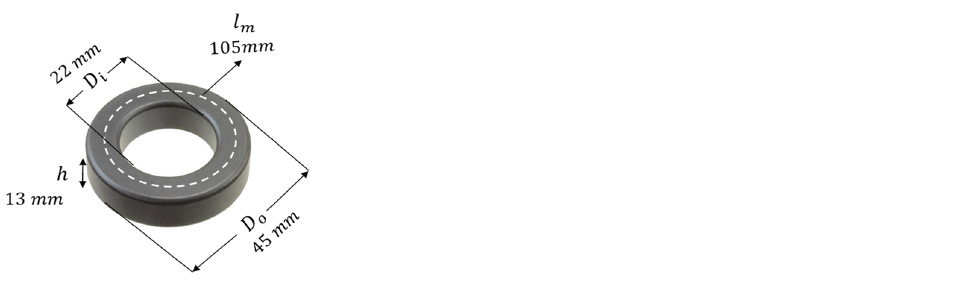
Figure 7. Required measurements for the application of the ASTM A772/A772M standard. As shown in Figure 6, it was necessary to generate a high-frequency sinusoidal current, which was generated by implementing the resonant inverter, as seen in Figure 8, where the inductor of the resonant network contains the test core and must be in resonance with the capacitor. The design of the resonant inverter takes into account the inductance of the primary winding of each inductor “ L p ”, where the reactance of this inductor should be of the same value as the reactance of the capacitor “ C p ”. The value of the resonant capacitor is determined as follows: